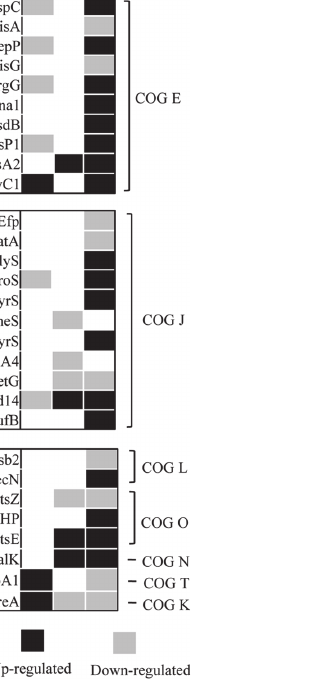
Fig 3. Changes in the protein profile during the response to an acid environment in Bifidobacterium . Line I, the value = the abundance of protein in the pre-stressed group were normalized against the control group cells; Line II, the value = the abundance of protein in the control-pH 3.5 group were normalized against the control group cells. Line III, the value = = the abundance of protein in the pre-stressed-pH3.5 group were normalized against the pre-stressed group cells. Black, up-regulated by (cid:1) two-fold; gray, down-regulated (cid:1) two-fold; white, no significant change. The solid numbers in the corresponding lines I, II, and III are listed in the columns ATR * ,ASR ** ,and ASR *** , respectively, in Table A in S1